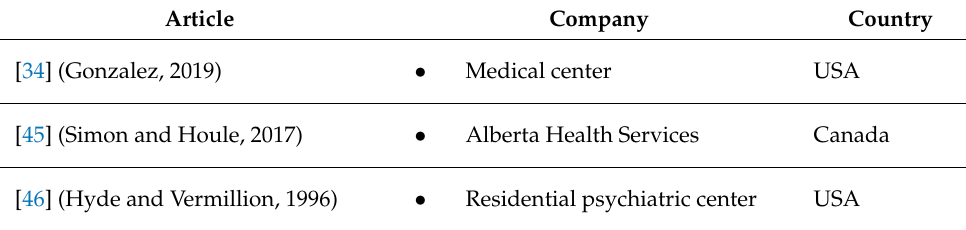
Table 7. Healthcare organizations (fifth